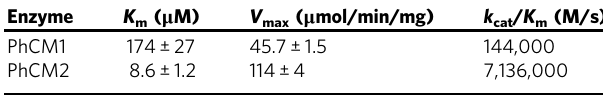
Table 1 Kinetic parameters of recombinant petunia